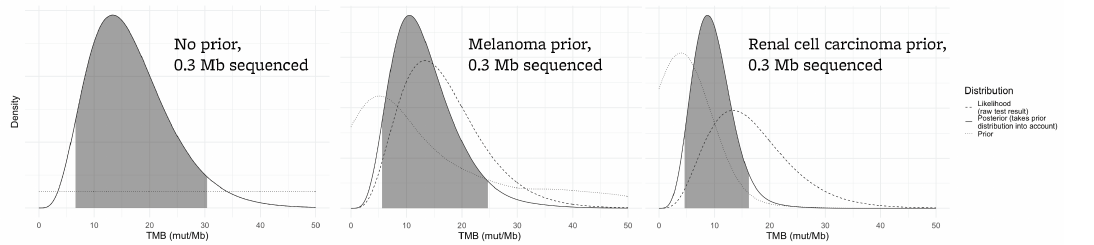
Figure 4. For a small assay sequencing 0.3 Mb, the confidence interval of a TMB result is affected by the tumor type that is being sequenced. Each plot assumes an assay result of 12 mut/Mb. The left panel demonstrates the likely true TMB result (gray area) without taking prior knowledge of tumor TMB distributions into account. The true TMB result will likely be higher in a tumor type that tends to have higher TMB values (such as melanoma, center plot) versus a tumor type that tends to have lower TMB values (renal cell carcinoma, right